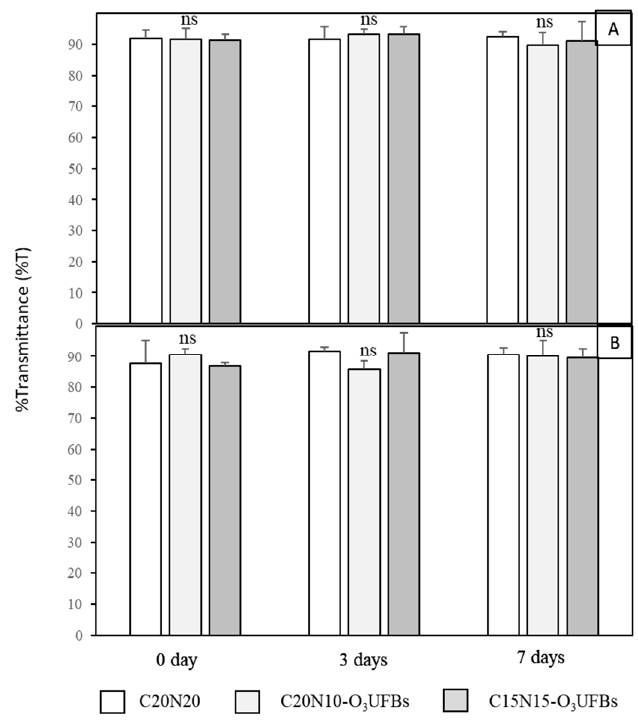
Figure 6. Turbidity of coconut water of trimmed coconuts dipped in C 20 N 10 -O 3 UFBs and C 15 N 15 - O 3 UFBs compared with C 20 N 20 when stored at 2 °C for 0 days (before storage) ( A ) and 30 days ( B ). After storage, all coconut fruits were transferred to 8–10 °C for 7 days and coconut water turbidity was evaluated on days 0, 3, and 7. ns: not significantly different.